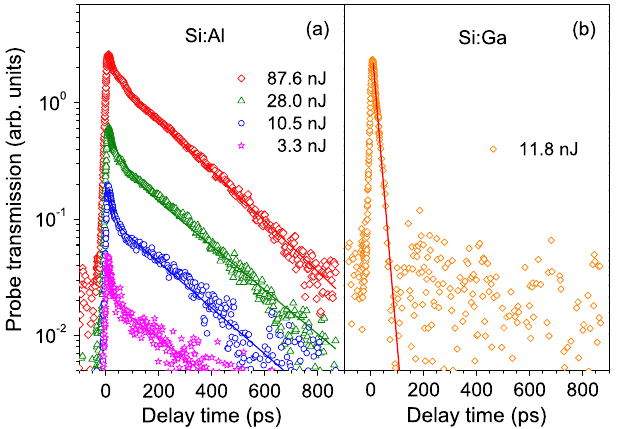
FIG. 4. Same as Fig. 3(a) for Si:Al and Si:Ga samples at 5 K. (a) Optical transition line 1 for Si:Al , and (b) optical transition line 1 for Si:Ga .